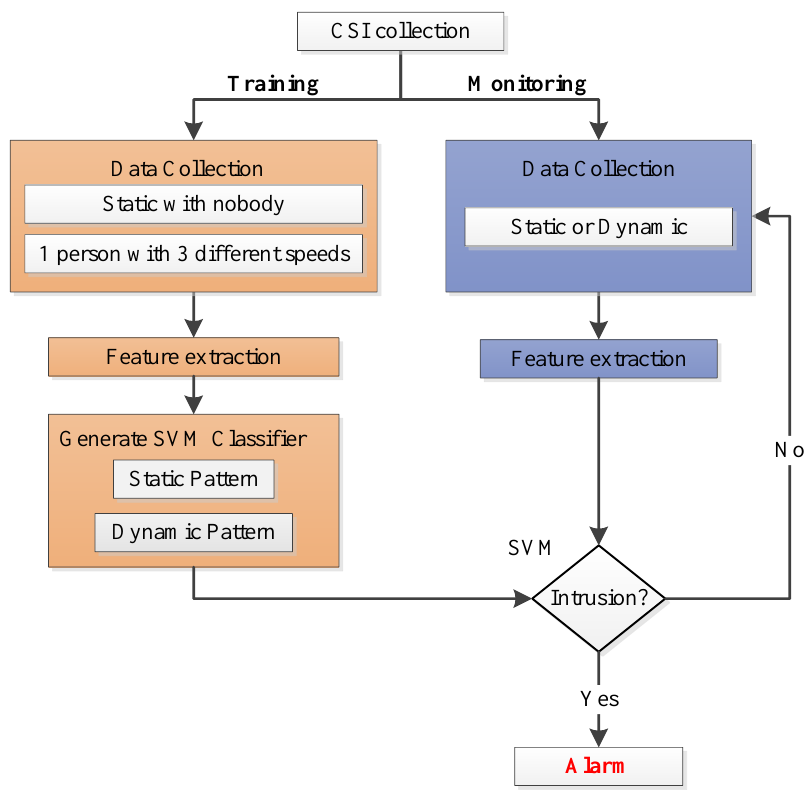
Figure 2. System